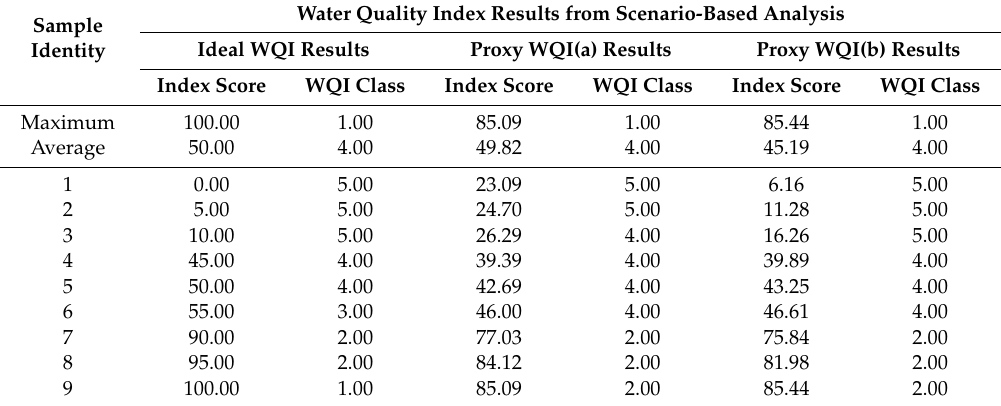
Table 7. Comparison of the Developed Proxy Water Quality Indices (a) and (b) Using Scenario-Based Analysis to Establish the Functionality and Predictive Capacity of the Models.